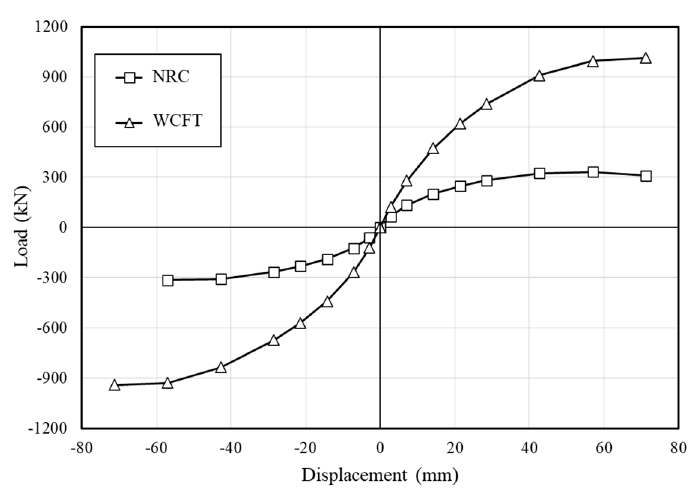
Figure 9. Envelope curves. Figure 9. Envelope